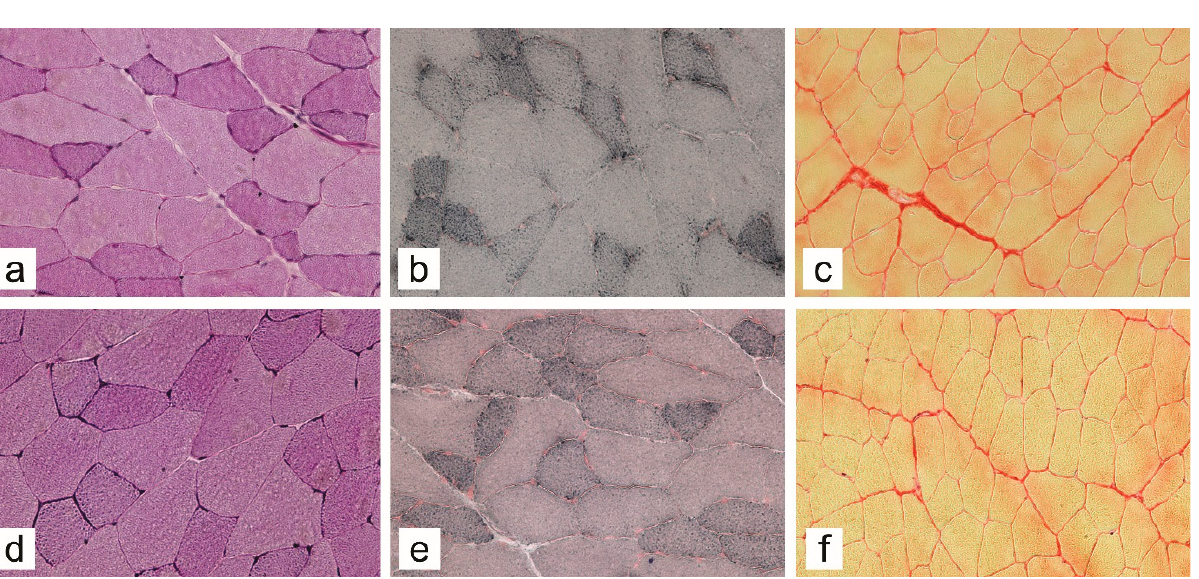
Figure 5. Glycogen, lipid, and collagen compositional changes determined by histochemical analysis of the gluteus maximus and gastrocnemius muscles of 13-week-old non-diabetic mice ( n = 9) (Y-NDM), 13-week-old STZ-induced diabetic mice ( n = 9) (Y-STZ-DM), 54-week-old non-diabetic mice ( n = 9) (O-NDM), and 54-week-old HFD-induced obese insulin-resistant mice ( n = 9) (O-HFD-DM). Data are means and standard deviation (SD); # p < 0.05, ## p < 0.01, #### p < 0.0001 for comparison between study groups and * p < 0.05, ** p < 0.01, *** p < 0.001, **** p < 0.0001 for comparison of gluteus maximus vs. gastrocnemius in the same study group (two-way ANOVA with repeated measures).